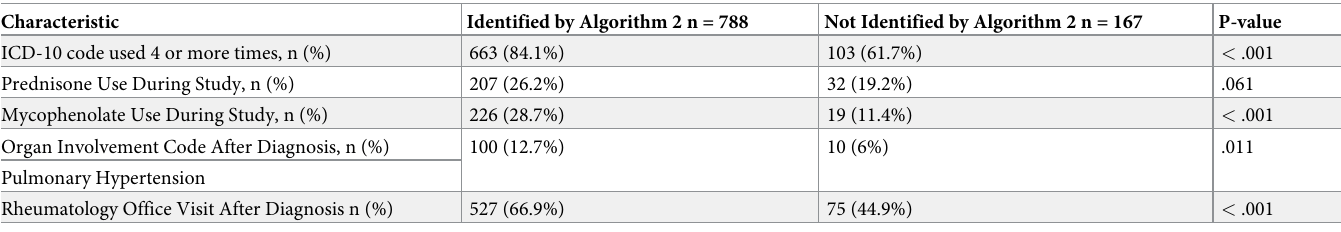
Table 4. Select comparisons of patients identified by Algorithm 2 compared to patients with ICD-10 code use at least two